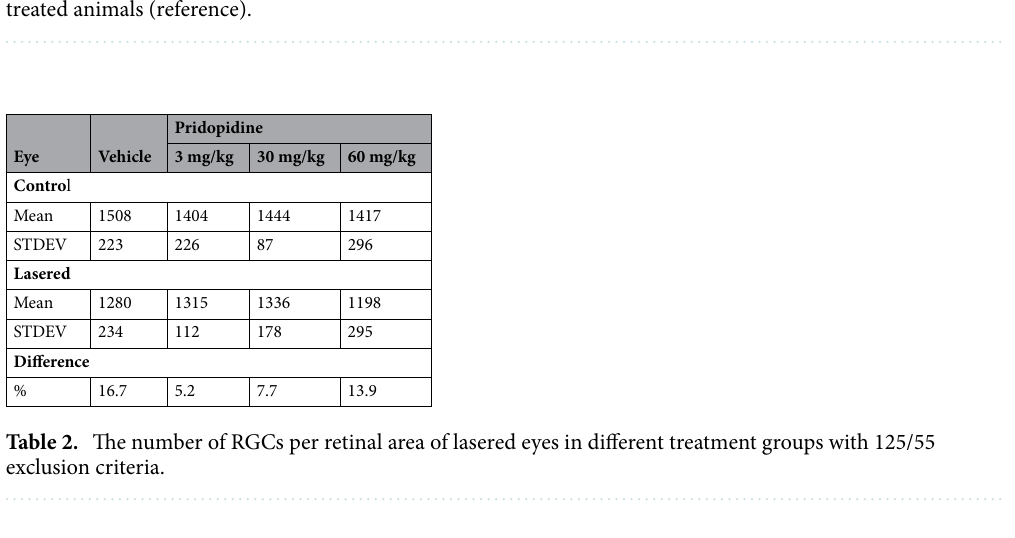
Table 1. Area under curve (AUC) of IOP in different treatment groups and in contralateral eyes of vehicle- treated animals (reference).